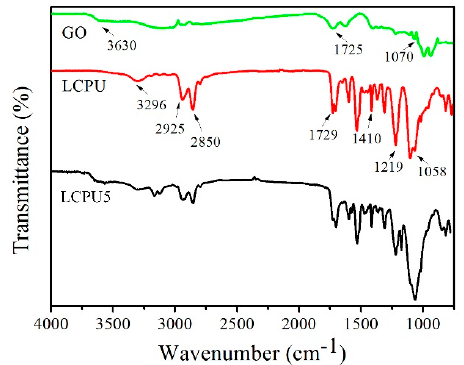
Figure 2. Fourier transform infrared (FT-IR) spectra of GO, liquid crystalline polyurethane (LCPU), and LCPU with 5 wt % GO (LCPU5).